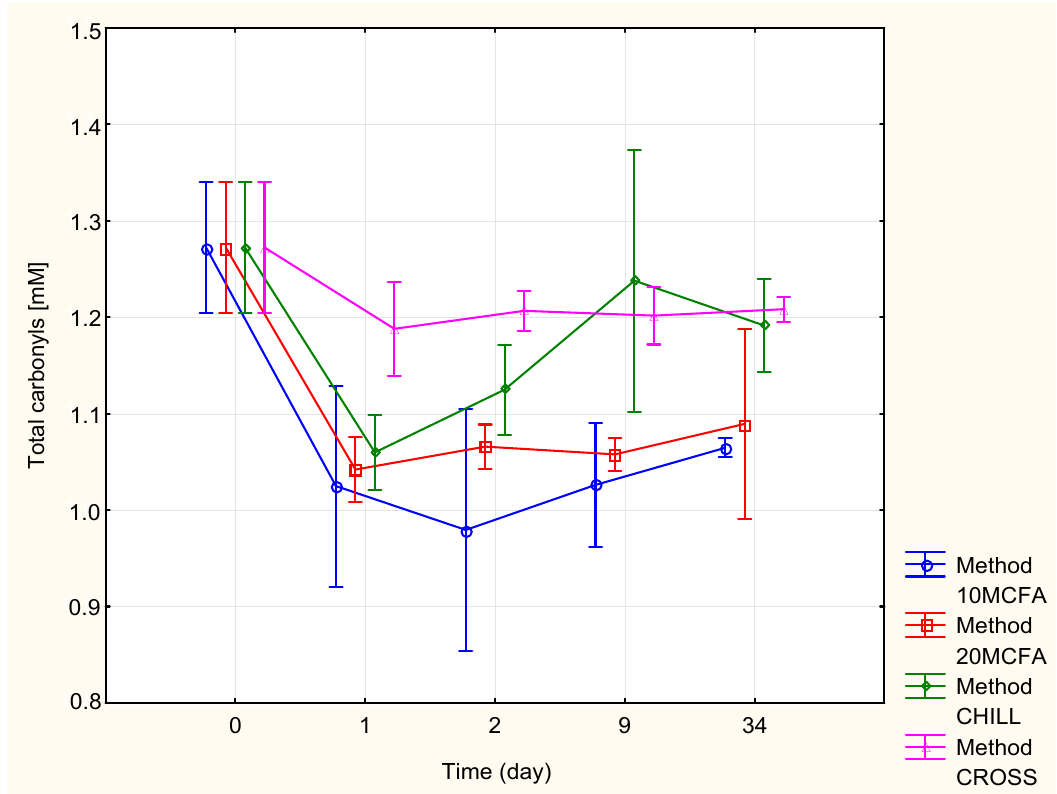
Figure 4. Changes in the total carbonyl content.